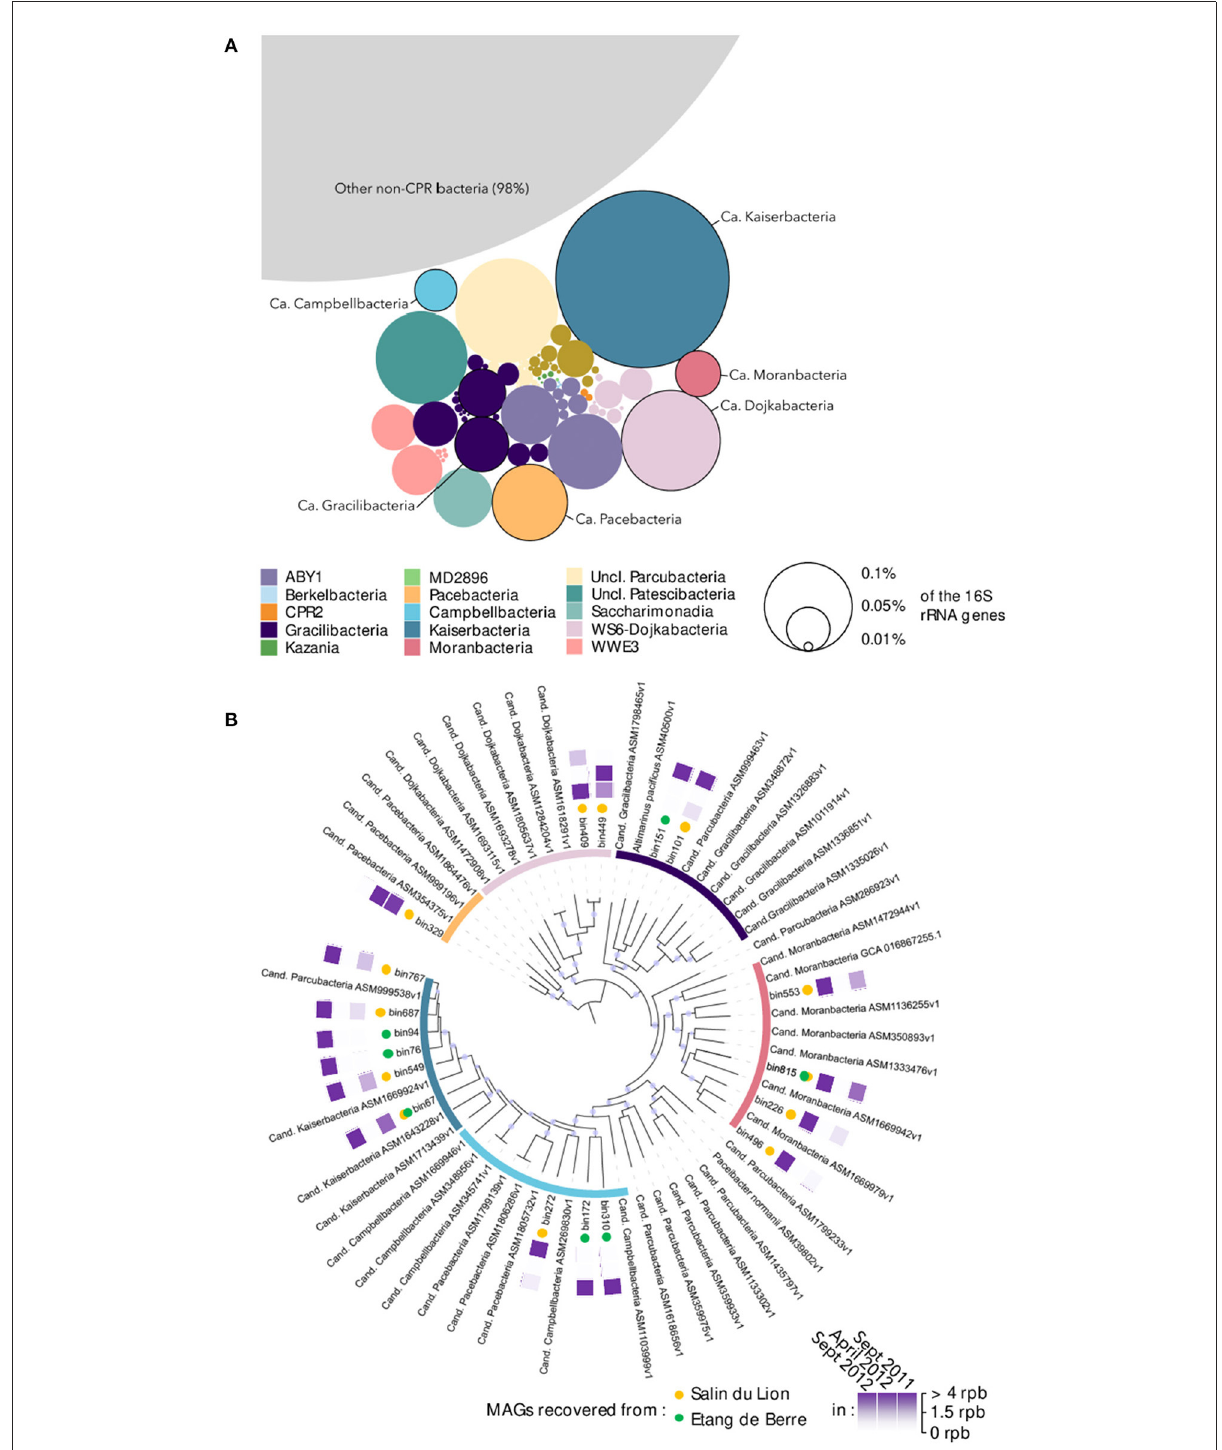
FIGURE1 (A) Overall Patescibacteria community composition in the microbial mats based on 16S rRNA genes identified in the metagenomic dataset. The size of the bubbles represents the average relative proportion of each lineage across all samples. Circled bubbles indicate lineages with representative MAGs. (B) Phylogenomic tree of the Patescibacteria MAGs recovered in the microbial mats. The tree was constructed based on concatenated ribosomal protein genes alignment with the closest representative genomes available on NCBI. The purple points in the branches of the tree represent bootstrap values > 0.8. The inner circle is color coded as in (A) . Yellow/green dots indicate the origin of the MAG, respectively. Purple squares are heat maps indicating the season in which MAGs were detected based on the coverage of the MAGs (rpb, reads per bases). For example, bin767 was detected in September 2011, not detected in April 2012, and strongly detected again in September